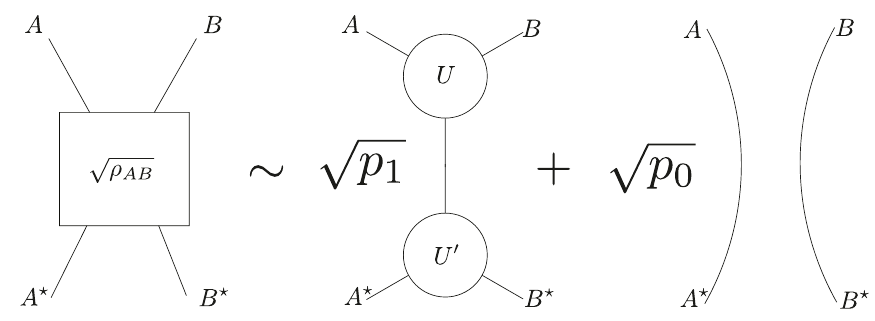
Figure 14 . An illustration of eq. (3.93). We argue that the canonical purification is effectively described by a sum over tensor network states. The first state comes from the natural doubling procedure outlined in ref. [27] for the connected entanglement wedge of the original network in figure 7 and the second is the trivial factorized network which is obtained by doubling the triv- ial/disconnected entanglement wedge of the original